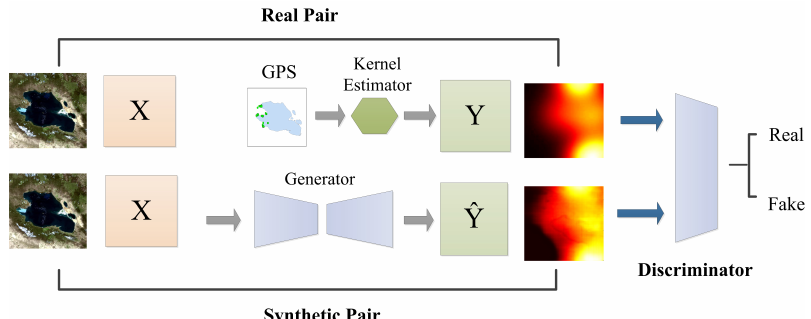
Figure 1. Using the adversarial framework to simulate the kernel-based home range estimator. X is the time-series remote sensing image, and Y is the corresponding home range map. The generator, G, learns the mapping function X → Y . The discriminator D tries to classify the real and synthetic data–target pairs. Both G and D are deep convolutional neural